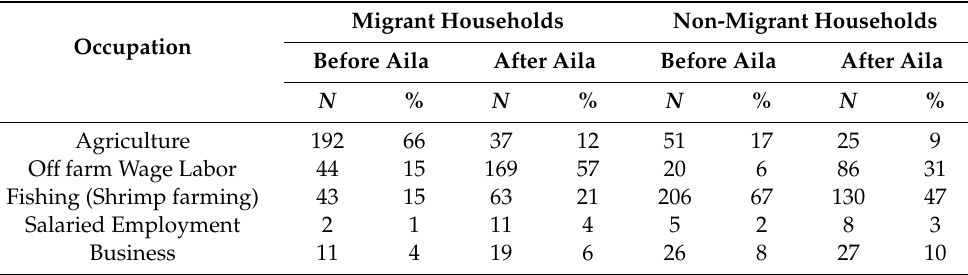
Table 7. Occupation before and after